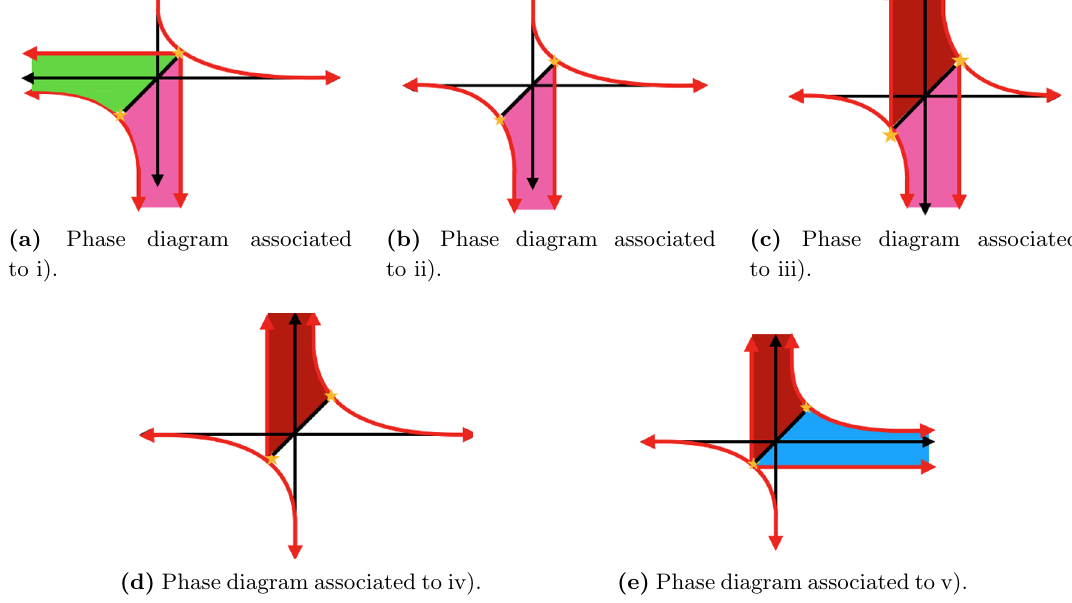
Figure 2. Various phase diagrams for the scenarios discussed in section 2.1, where m is on the y axis and M is on the